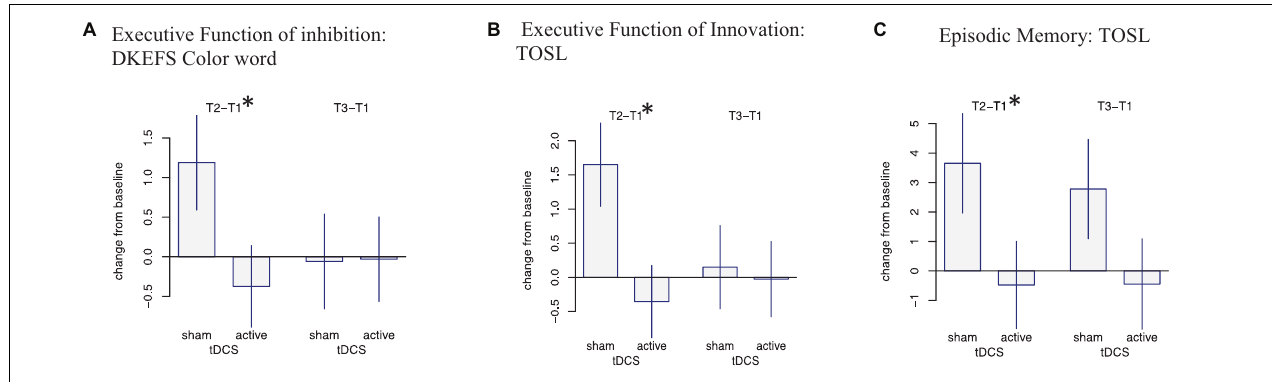
FIGURE 2 | Mixed Model Effects: Immediate cognitive gains (T2-T1) in s-tDCS + SMART group (A) Executive Function of Inhibition: DKEFS Color word interference ( p = 0.047), (B) Executive Function of Innovation: TOSL ( p = 0.010), and (C) Episodic Memory: Test of Strategic Learning (TOSL) ( p = 0.048) relative to the a-tDCS + SMART group. ∗ Indicates significant change (T2-T1) at p < 0.05.